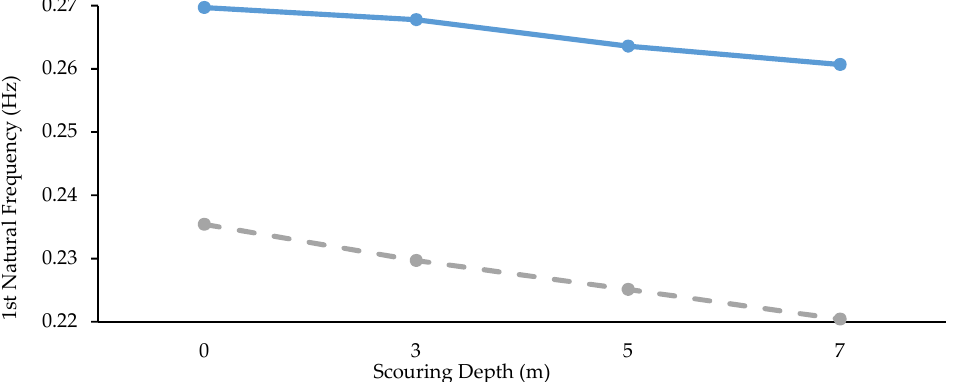
Figure 11. Evolution of the first natural bending frequency with the scouring depth for models Fix x (full line) and Pt x (dashed line).